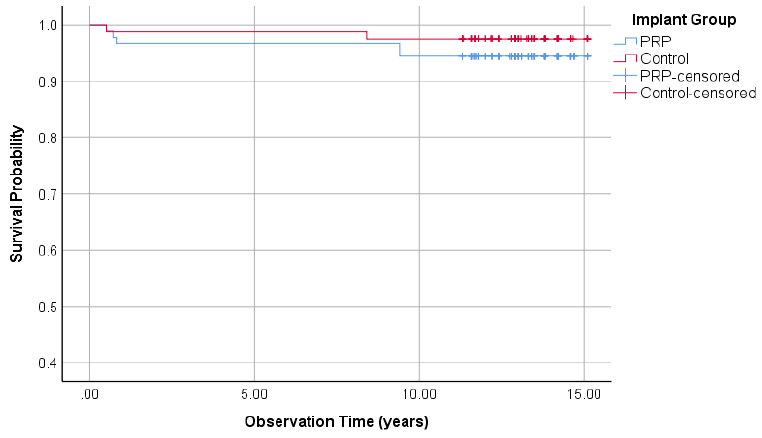
Figure 5. Survival rate of 171 implants in PRP and control side (split-mouth).